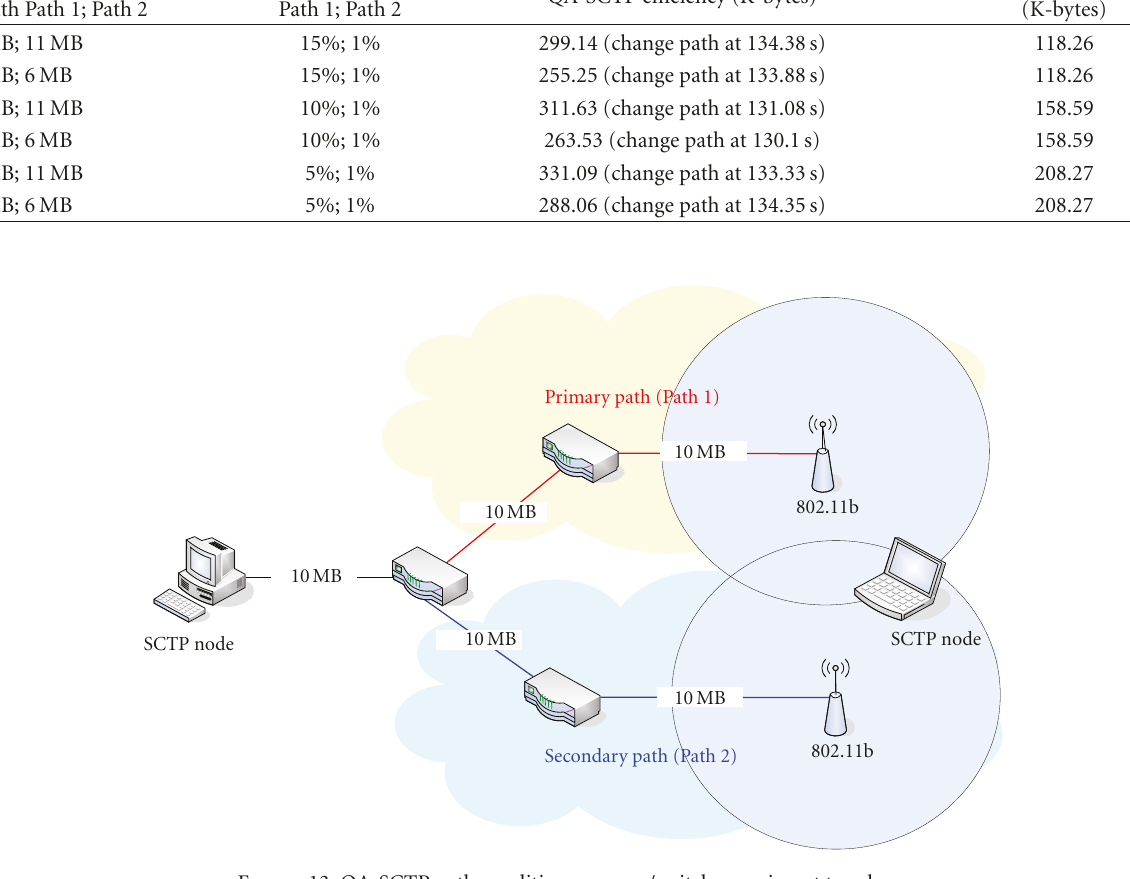
Figure 13: QA-SCTP path condition measure/switch experiment topology.